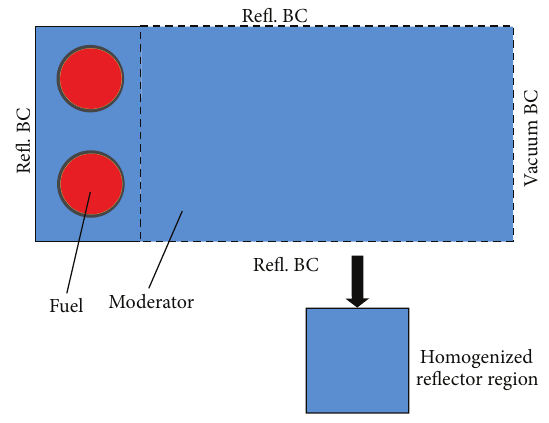
Figure 5: Water reflector cross-sections generation.